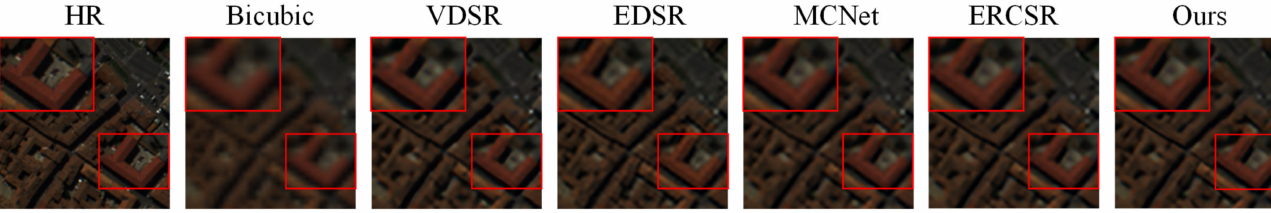
Figure 8. The reconstructed images of test images in the Pavia Centre dataset using various algorithms. Reconstructed images with spectral bands 60-35-13 as R-G-B channel with a scale factor of